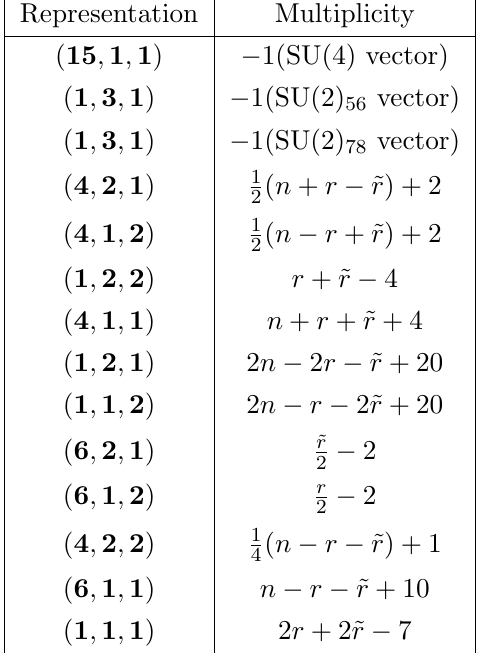
Table 20 . The spectrum for the con(cid:12)guration